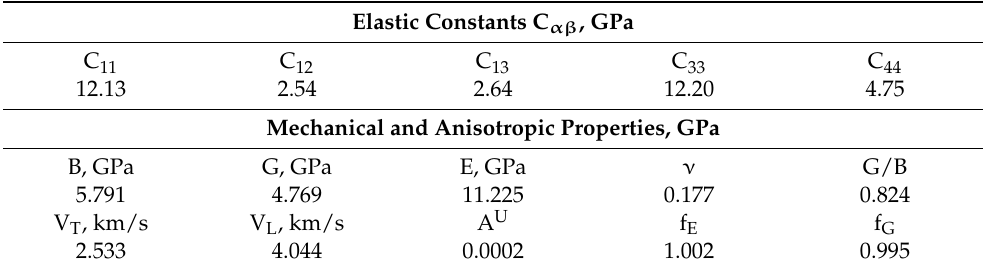
Table 8. Properties of empty sH gas hydrate at 0 K and − 1 GPa pressure.